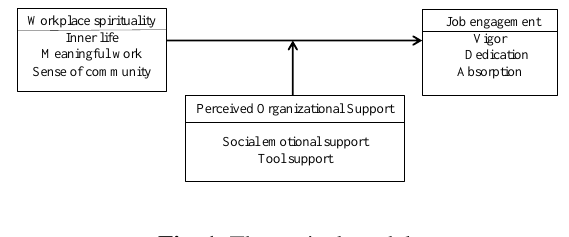
Fig. 1 Theoretical model. Table 1 Sample